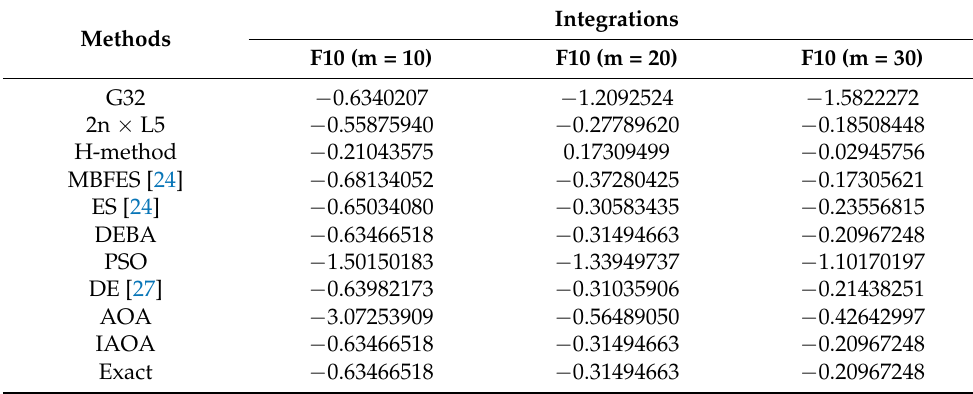
Table 12. Comparison of the experimental results for